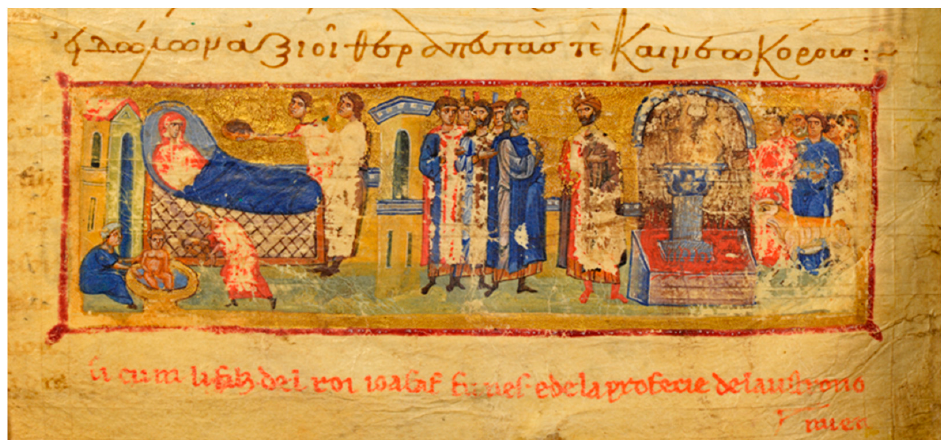
Figure 8. Mount Athos. Holy Iviron Monastery. Athon. Iviron 463, fol. 99r (detail). Ioasaph has a vision of the City of God. Photo: ©Holy Iviron Monastery, Mount Athos, all rights reserved.